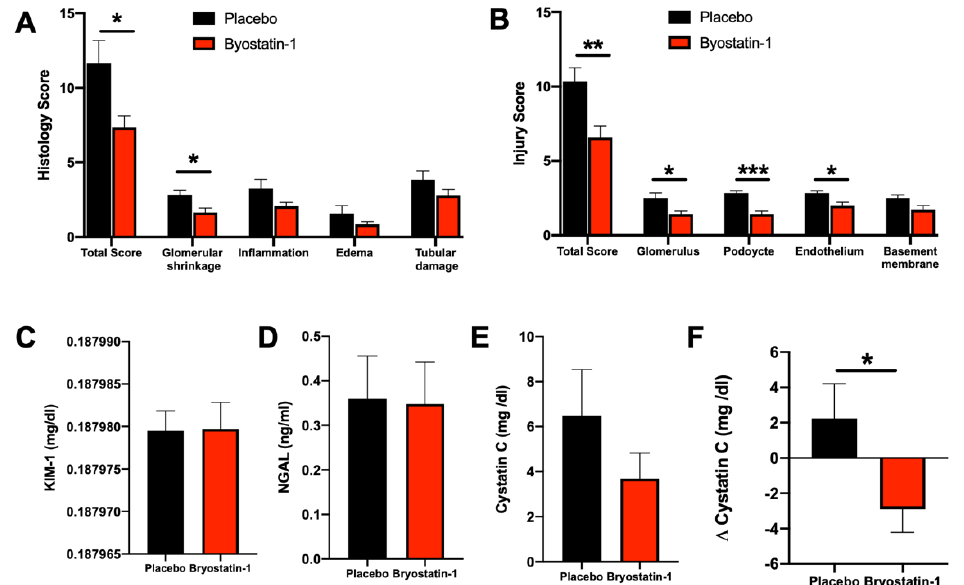
Figure 8. Bryostatin-1 protects renal autografts from ischemia-reperfusion injury and improves kidney function following renal autotransplantation. All analyses were conducted eight hours after reperfusion in a porcine model of renal autotransplantation with graft-specific treatment with placebo or Bryostatin-1 during 20-h static cold storage of renal autografts. ( A ) Histological injury score (consisting of glomerular damage (shrinking), inflammatory cell infiltrates, edema, and tubular damage) was significantly reduced in Broystatin-1-treated renal autografts. ( B ) Ultrastructural injury score (consisting of structural integrity of glomeruli, basement membrane, podocytes, and endothelium) was significantly improved in Broystatin-1 treated renal autografts eight hours of reperfusion. Urine levels of ( C ) kidney injury molecule-1 (KIM-1) and ( D ) neutrophil gelatinase-associated lipocalin (NGAL) were measured eight hours after reperfusion in a porcine model of renal autotransplantation with graft-specific treatment with placebo or Bryostatin-1 during 20-h static cold storage of renal autografts and found to be comparable between the two groups. ( E ) Plasma levels of Cystatin C were measured after 8 h of reperfusion, with a non-significant reduction in animals receiving Bryostatin-1 treated renal autografts. ( F ) When the individual delta (difference between pre-transplant and eight-hour reperfusion sample) was calculated, Bryostatin-1 elicited a significant reduction in ischemia-associated rise in plasma Cystatin C. All data are presented as mean values ± SEM from 6 (placebo) or 7 (Bryostatin-1) individually analyzed animals per group. Data were analyzed with Student’s t -test, and significance is indicated by the following symbols: * p < 0.05 versus placebo, ** p < 0.01 versus placebo, *** p < 0.001 versus placebo.